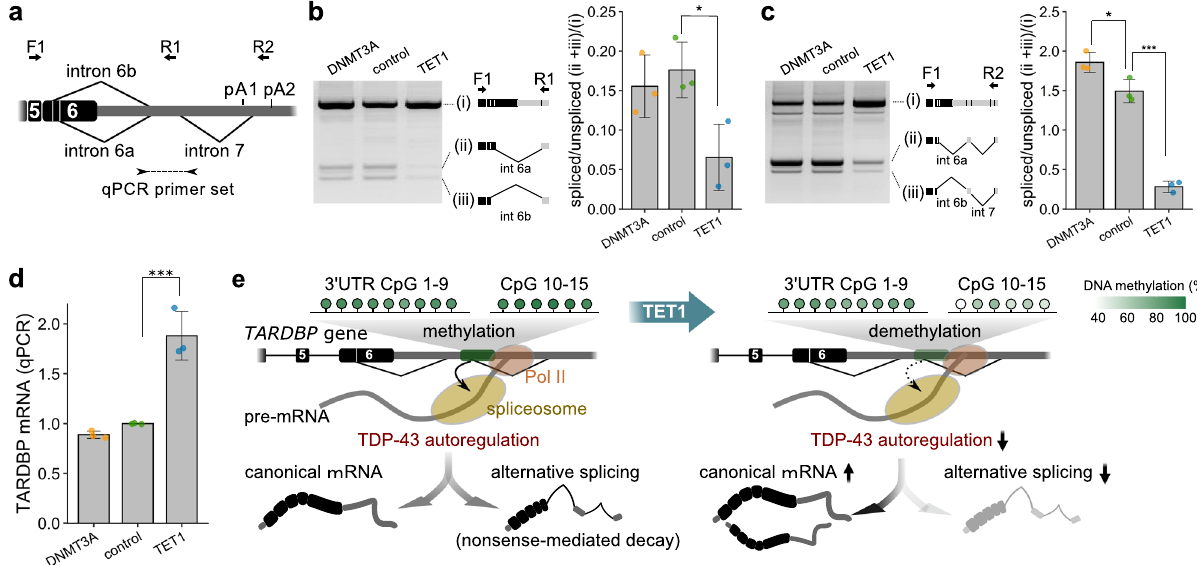
Fig. 3 Effect of the demethylation of TARDBP 3 ′ UTR CpGs on alternative splicing and mRNA expression of TARDBP . a Primer sets for the RT-PCR of TARDBP mRNA (arrows: F1/R1, F1/F2) and quantitative real-time PCR (arrowheads). b, c Analysis of alternative splicing by using primer set F1/R1 ( b ) or F1/ F2 ( c ) (mean ± SD, n = 3, Dunnett ’ s test). d Quantitative real-time PCR analysis of TARDBP mRNA using RPLP1 and RPLP2 as reference genes (mean ± SD, n